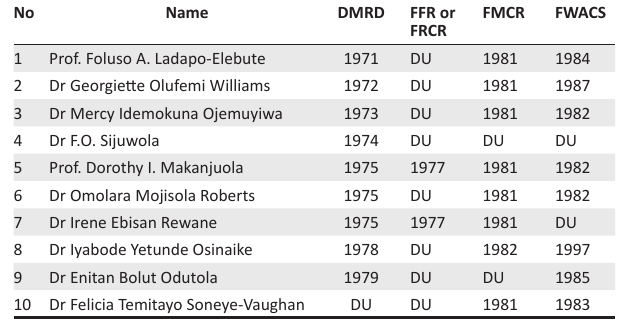
TABLE 2: Pioneer women radiologists in Nigeria.